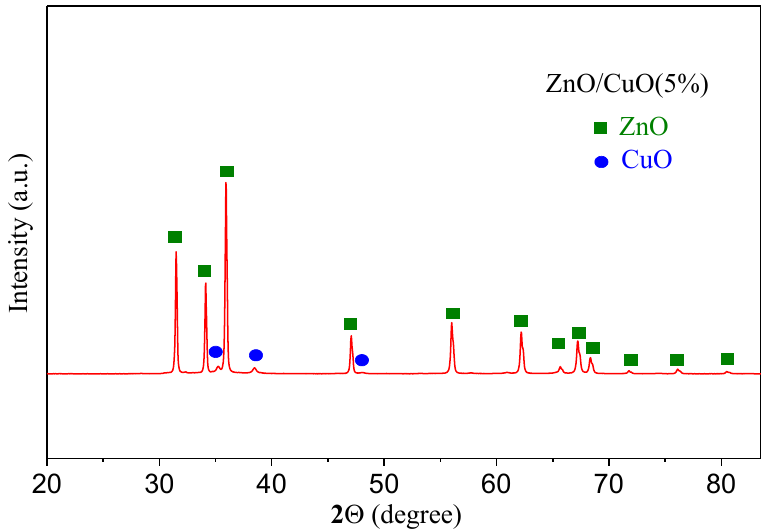
Figure 2. X-ray di ff raction (XRD) pattern of ZnO / Cu x = 1.25 O photocatalyst powder. For further details, Figure 2. X-ray diffraction (XRD) pattern of ZnO/Cu x = 1.25 O photocatalyst powder. For further details, see see text.